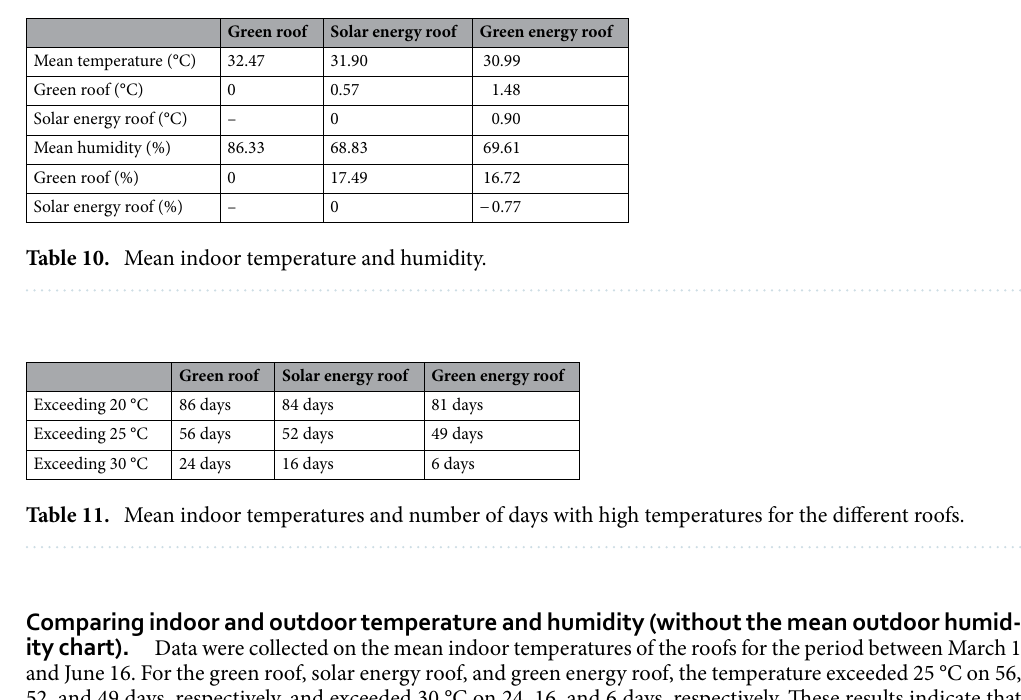
Fig. 10c, indicated large changes in outdoor temperatures and low indoor temperatures. The green roof exhibited the highest indoor temperature of 25.56 °C, followed by the solar energy roof (25.21 °C) and green energy roof (24.4 °C). The green energy roof could maintain low temperatures and therefore is suitable for tropical regions. Comparing the temperatures of the solar energy modules. Figure 11a presents comparisons between the temperatures of the solar panel modules between 05:10 and 06:30 (i.e., between sunrise and sunset